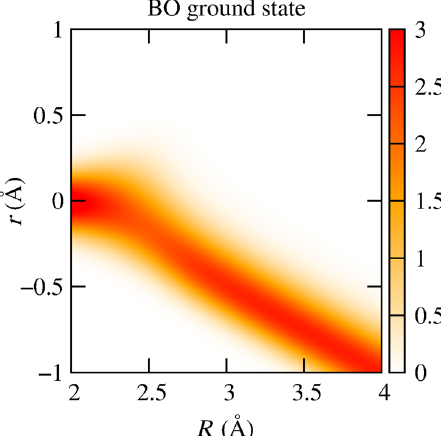
FIG. 2. Proton density corresponding to the BO ground state, showing that in its vibrational ground state and for large O ─ O distances, the proton tends to be localized around the oxygen atom O − because of the asymmetry of the potential.